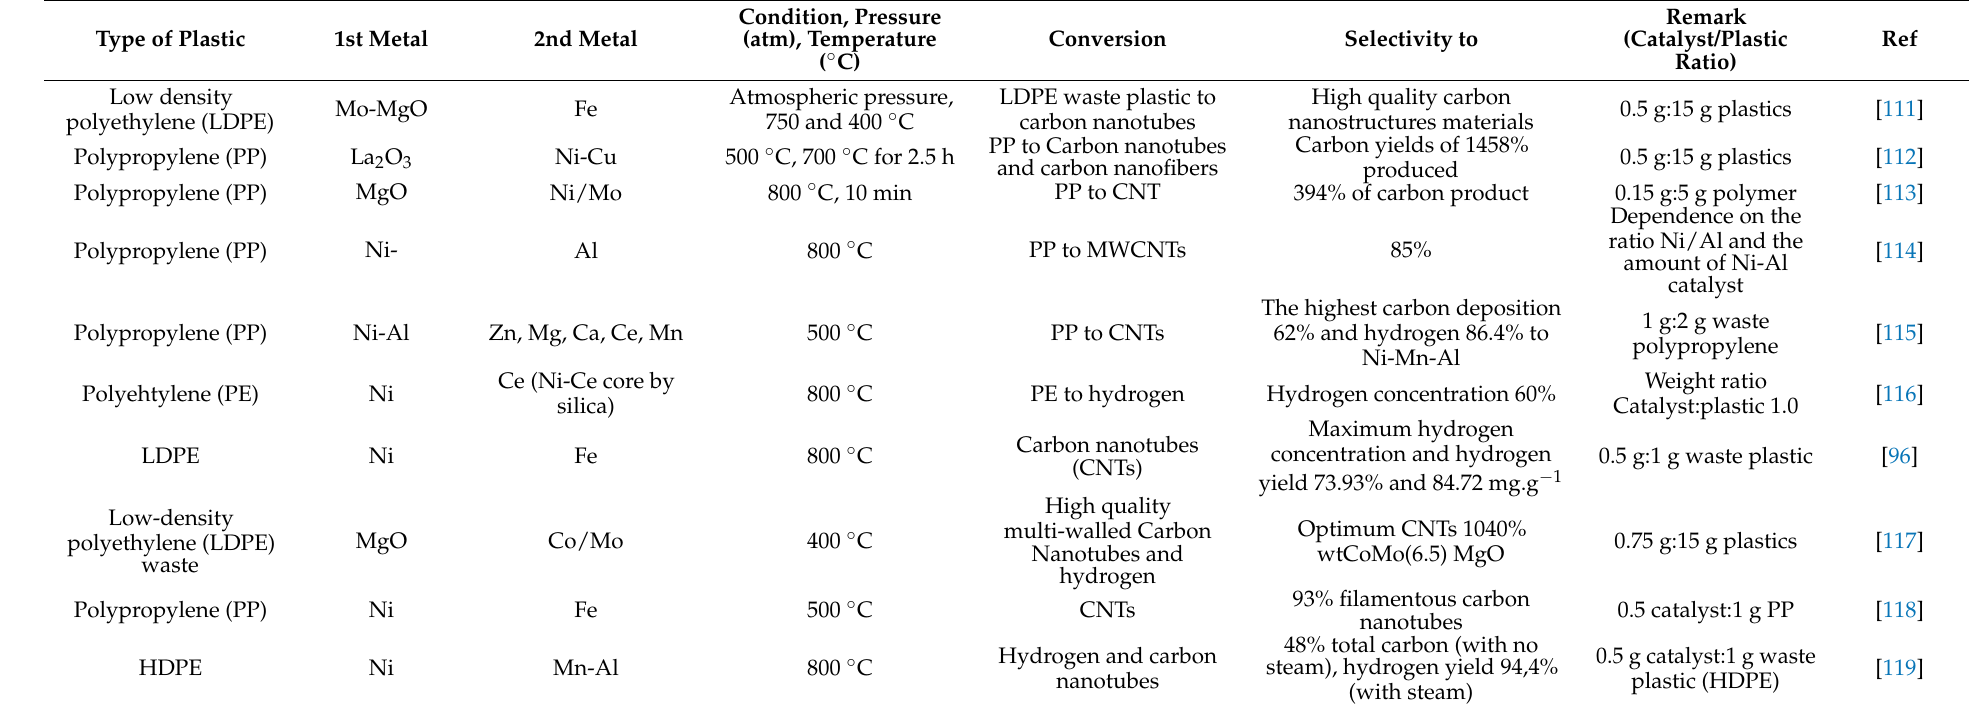
Table 4. Recent reports bimetallic catalysts for pyrolysis of